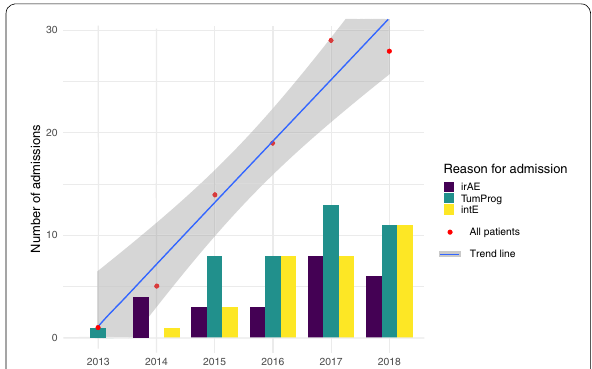
Fig. 1 Bar plots of the number and reasons for admission over the study period ( p < 0.001). irAE immune‑related adverse event, TumProg complication related to tumor progression, intE intercurrent